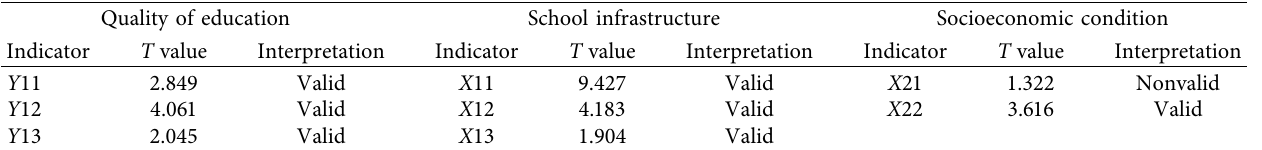
Table 5: The significance test results.